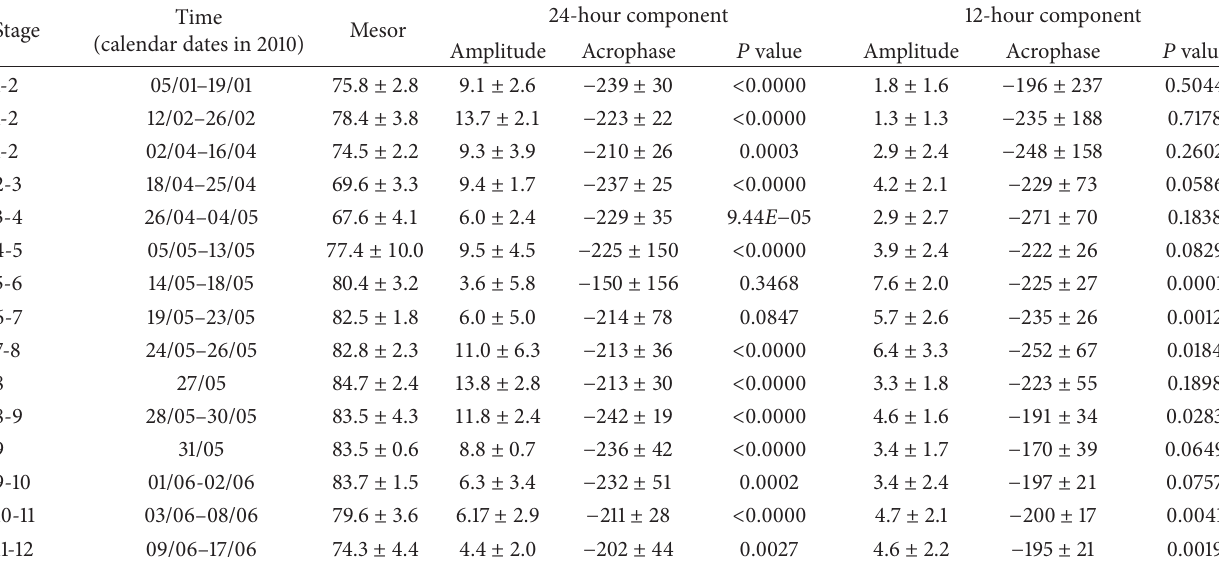
Table 2: Dynamics of the diastolic blood pressure in